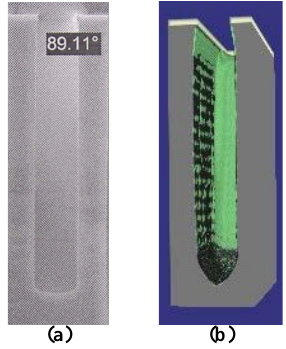
Figure 8. The SEM photography ( a ), and the simulation result ( b ) of a single trench.